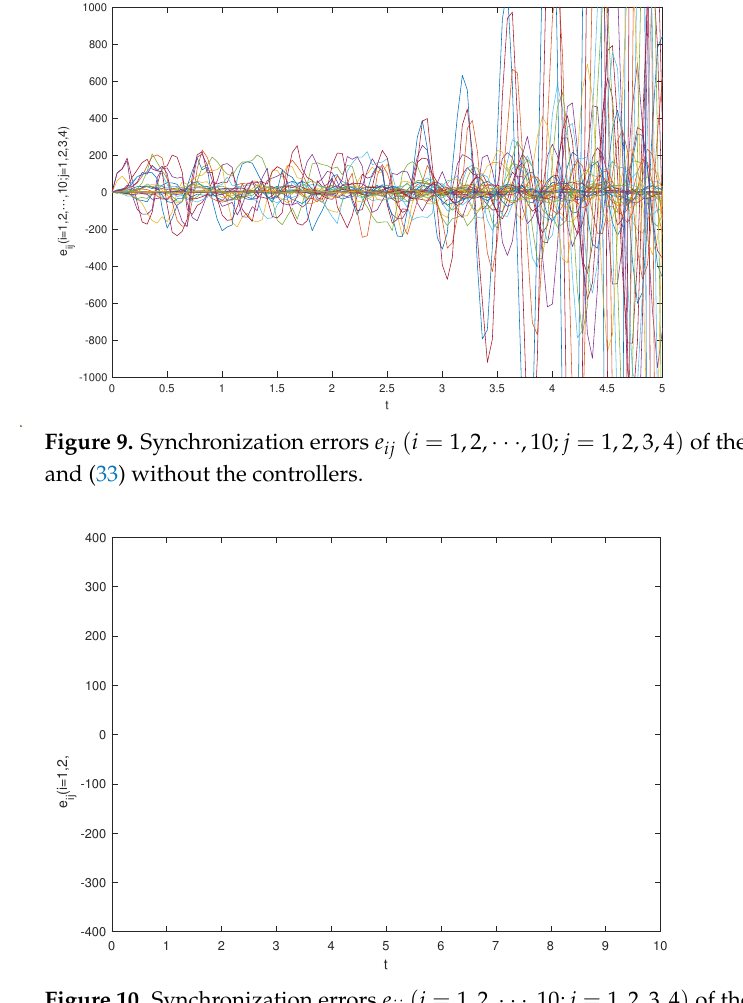
Figure 10. Synchronization errors e ij ( i = 1,2, · · · ,10; j = 1,2,3,4 ) of the fractional-order system (32) and (33) with the